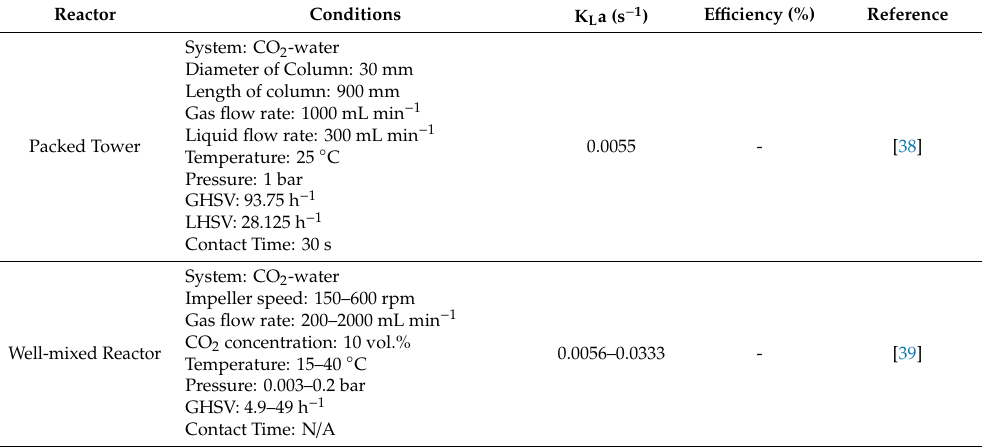
Table 3. Comparison of K L a and e ffi ciency for absorption system with the various reactor types.